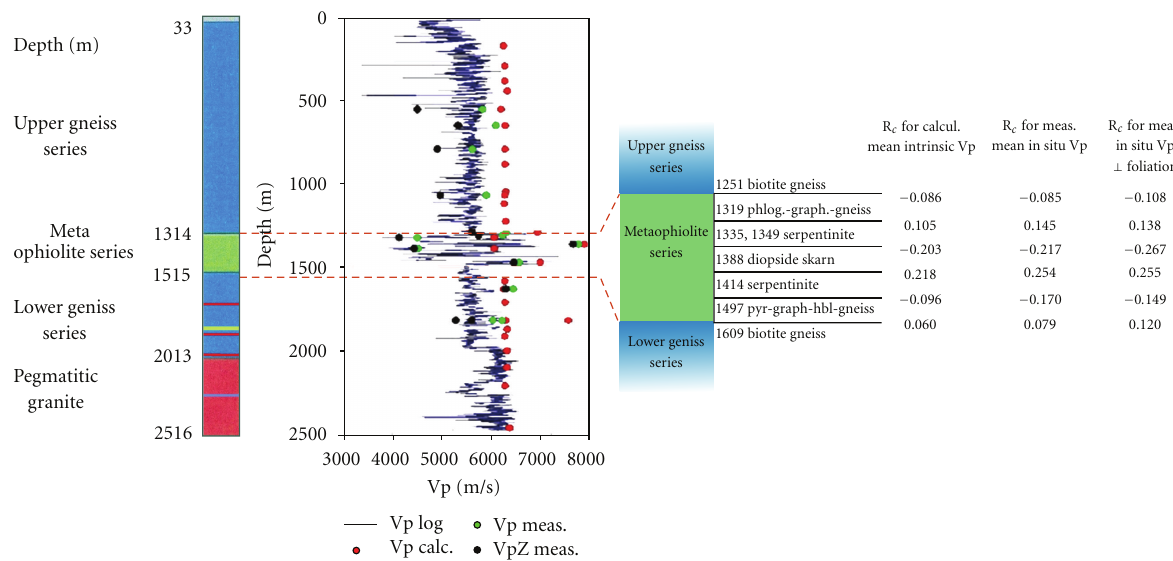
Figure 4: Comparison of sonic log data of the Outokumpu scientific drill hole with calculated intrinsic and measured in situ velocities of the investigated samples (left) along with calculated reflection coe ffi cients ( R c ) for the di ff erent lithologies